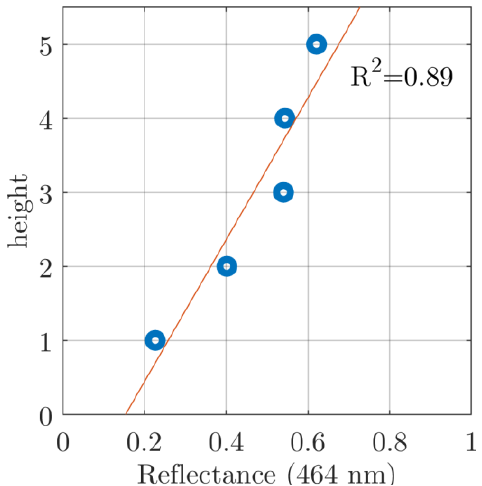
Figure 8. A 2D plot of the cube’s EM reflectance at 464 nm vs. its height in each pattern. The coefficient of determination, R 2 , shows a significant relationship between them.